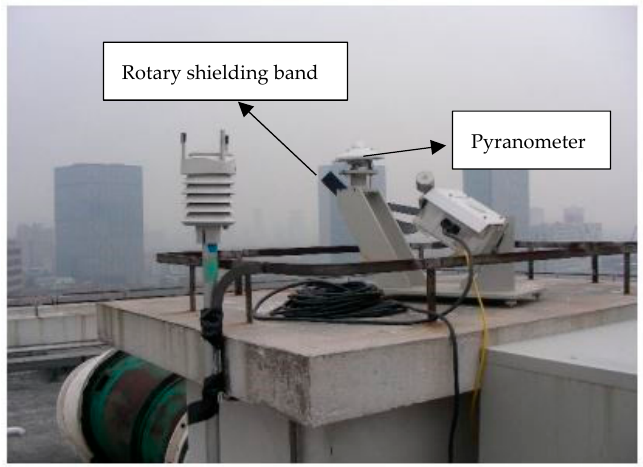
Figure 4. Installation situation of on-site pyranometer with totary shielding band.